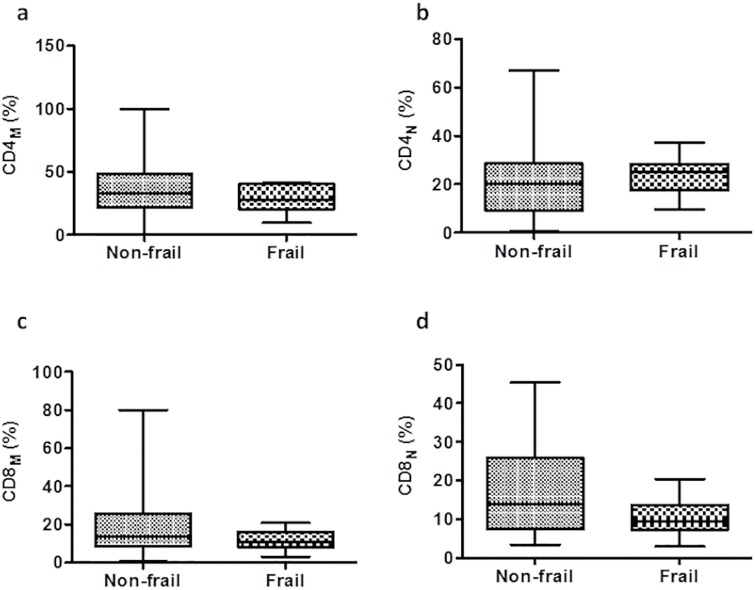
Percentages of CD4+ and CD8+ T cell subpopulations in frail and non-frail groups.PBMCs were analyzed by flow cytometry by first gating on the total mononuclear cells and then on the CD3+ T cells. The frequency of CD4M (a), CD4N (b), CD8M (c), CD8N (d) T cells was then determined. Box plots represent median with 25th and 75th percentile borders, error bars represent 10 th and 90 th percentile. The mean ± SEM for each group is given below the bar for that particular group.